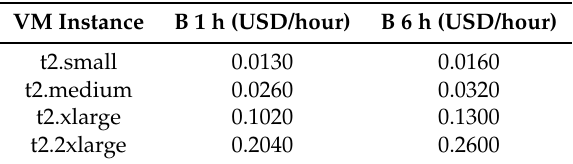
Table 2. Spot block instance (B) characterization price per block